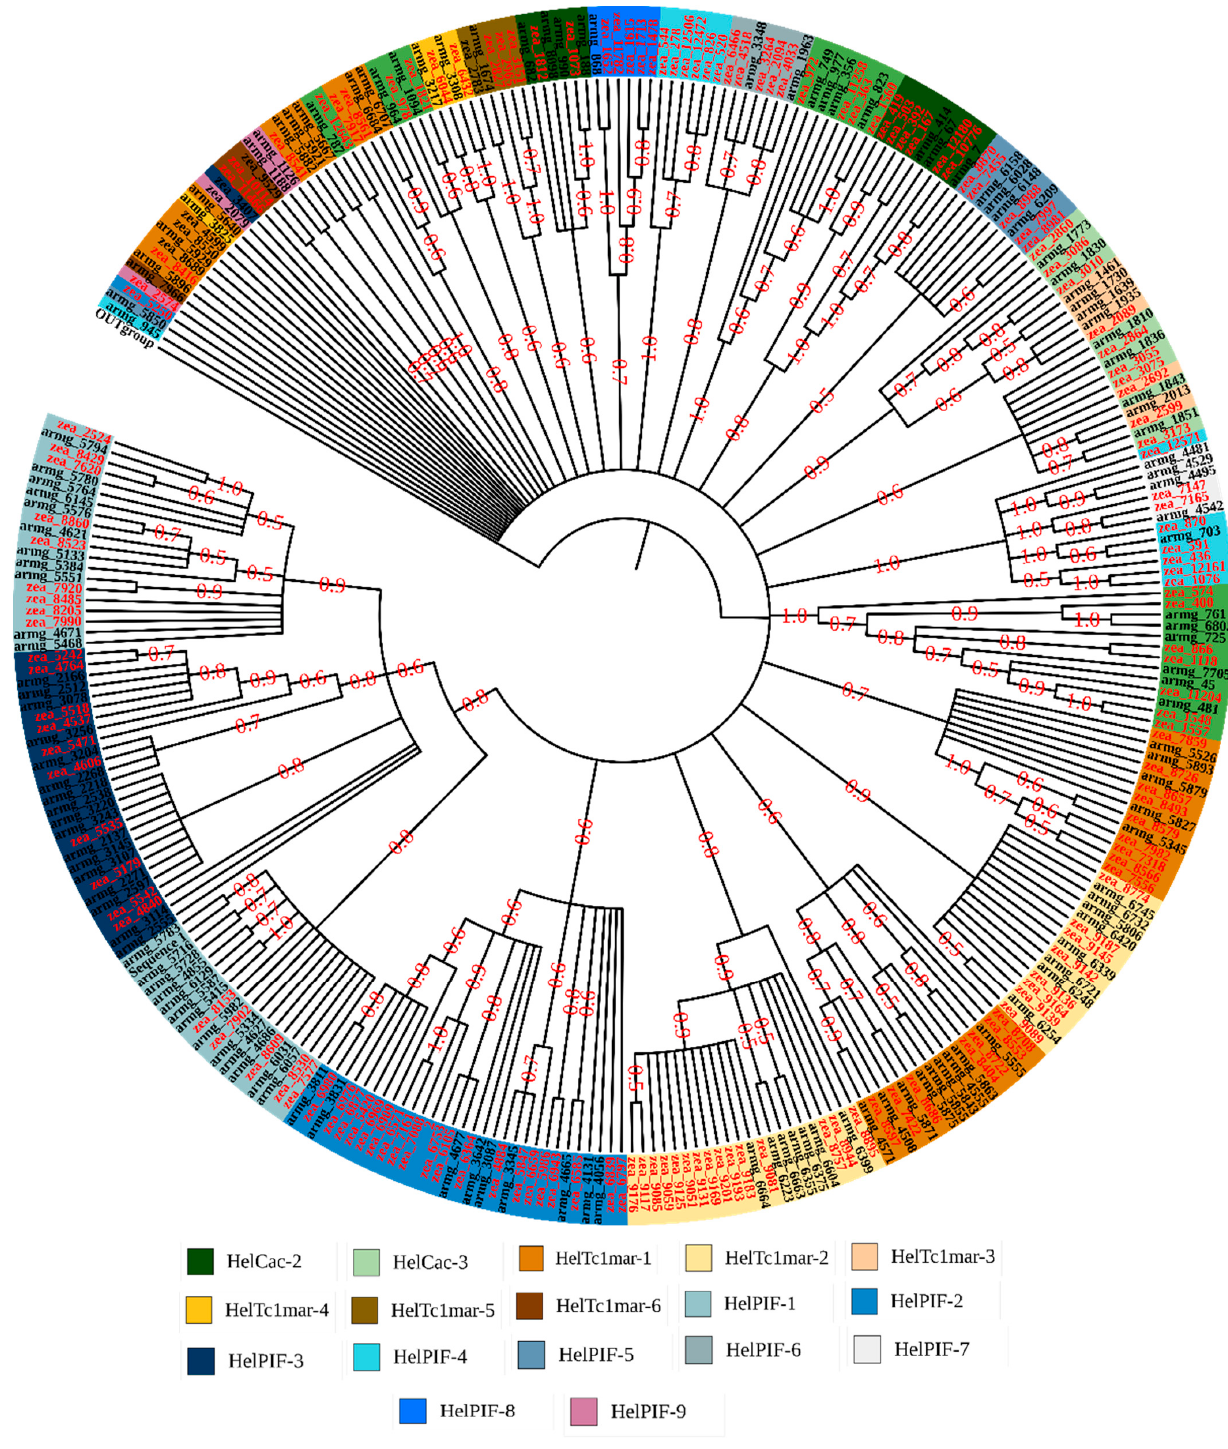
Figure 1. Phylogenetic analysis of MITE families from H. armigera and H. zea. The analysis was performed using the identified MITE family members having 80:80 coverage. The 18 MITE families were separated into different clades by a maximum likelihood phylogenetic analysis (model HKY85) with 500 bootstrap replications (only bootstrap value ≥ 0.5 are showed). The families belonging to the three MITE superfamilies, TC1/mariner, PIF harbinger and CACTA, are indicated in different colors and MITE members from H. armigera H. zea are indicated in black and red, respectively.